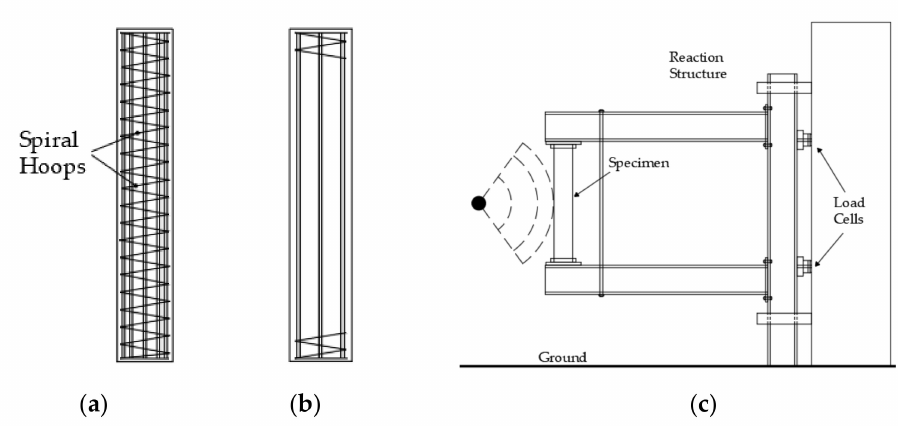
Figure 5. Reinforcement position in specimens: ( a ) RC column and ( b ) CFFT column; specimen position: ( c ) test setup [18].